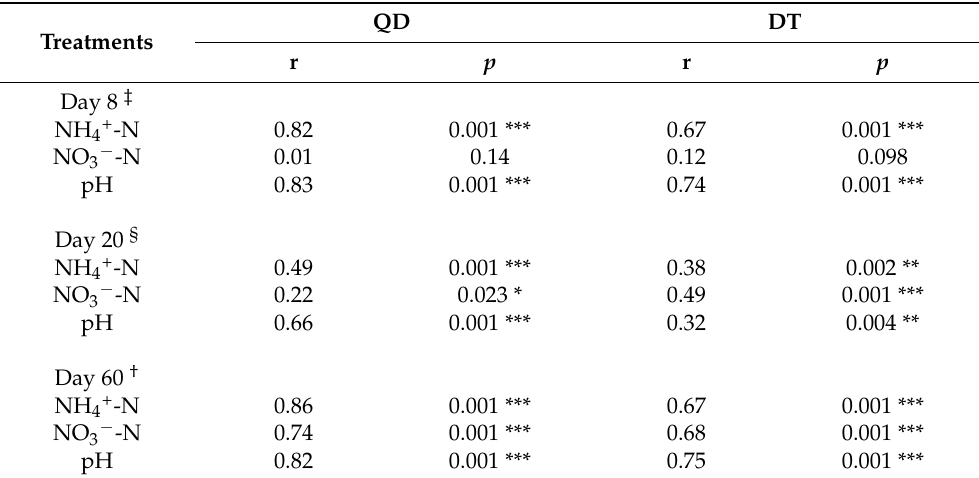
Table 5. The correlations (r) between soil chemical properties and bacterial communities determined by Mantel